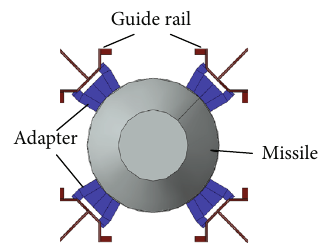
Figure 10: Missile and guide rail assembly diagram.